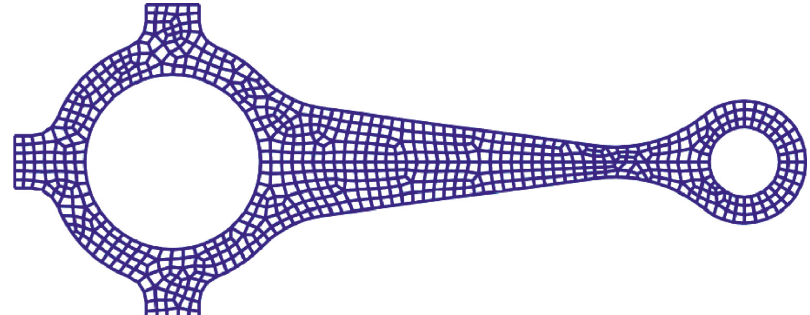
Figure 23: Domain discretization of connecting bar using four-node elements. Table 10: First ten natural frequencies (